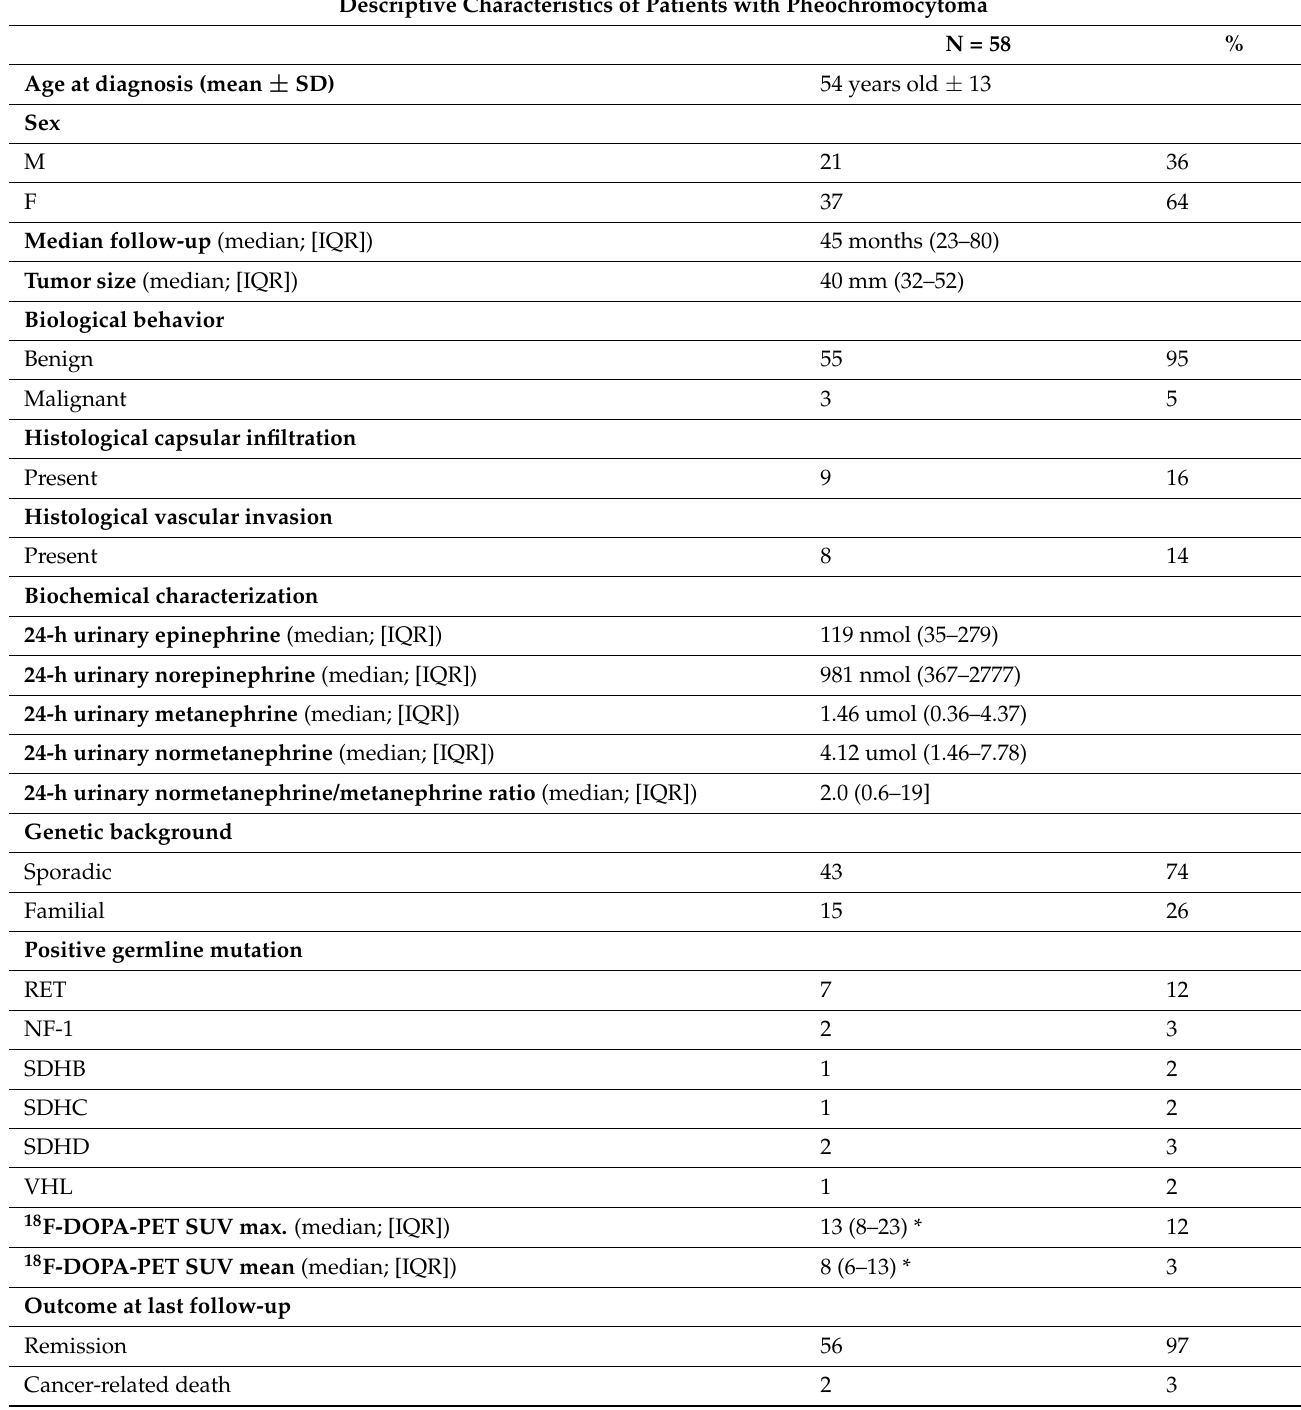
Table 1. Descriptive characteristics of patients with pheochromocytoma. Descriptive Characteristics of Patients with